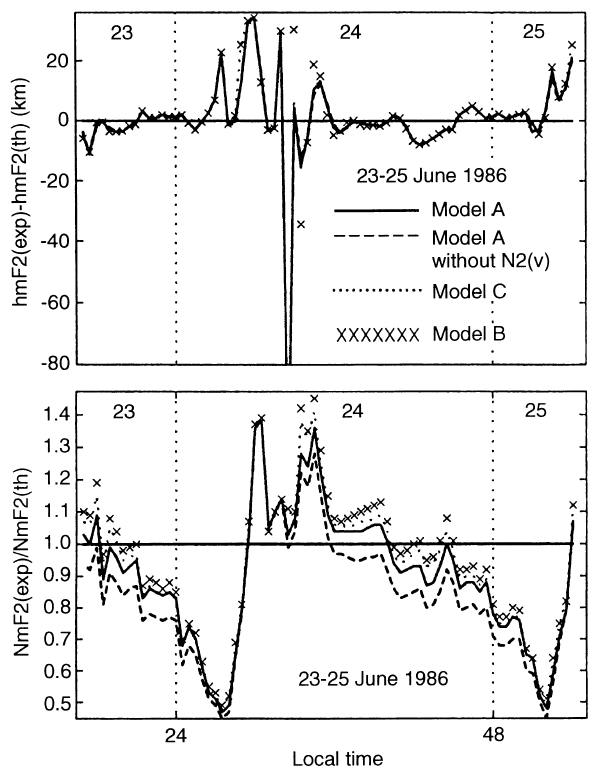
Fig. 5. IZMIRAN model results for 23–25 June 1986 at Millstone Hill. Top: di(cid:128)erences between the measured hmF2 (exp) and modeled hmF2 (th); bottom: ratios of the measured NmF2 (exp) to the modeled NmF2 (th). The MSIS-86 model with the adjusted atomic oxygen density is used in the IZMIRAN model between 0500 LT and 0800 LT on 24 June at all altitudes. The solid lines give results including e(cid:128)ects of N 2 (v) and using the rate coe(cid:129)cient for quenching of O (cid:135) (cid:133) 2 D (cid:134) by atomic oxygen K D (cid:136) 10 (cid:255) 10 cm 3 s (cid:255) 1 (model A). The dashed lines show results using K D (cid:136) 10 (cid:255) 10 cm 3 s (cid:255) 1 (model A), but without e(cid:128)ects of N 2 (v). The dotted lines (model C) and crosses (model B) show results including e(cid:128)ects of N (v) and using K D (cid:136) 5 (cid:2) 10 (cid:255) 12 cm 3 s (cid:255) 1 2